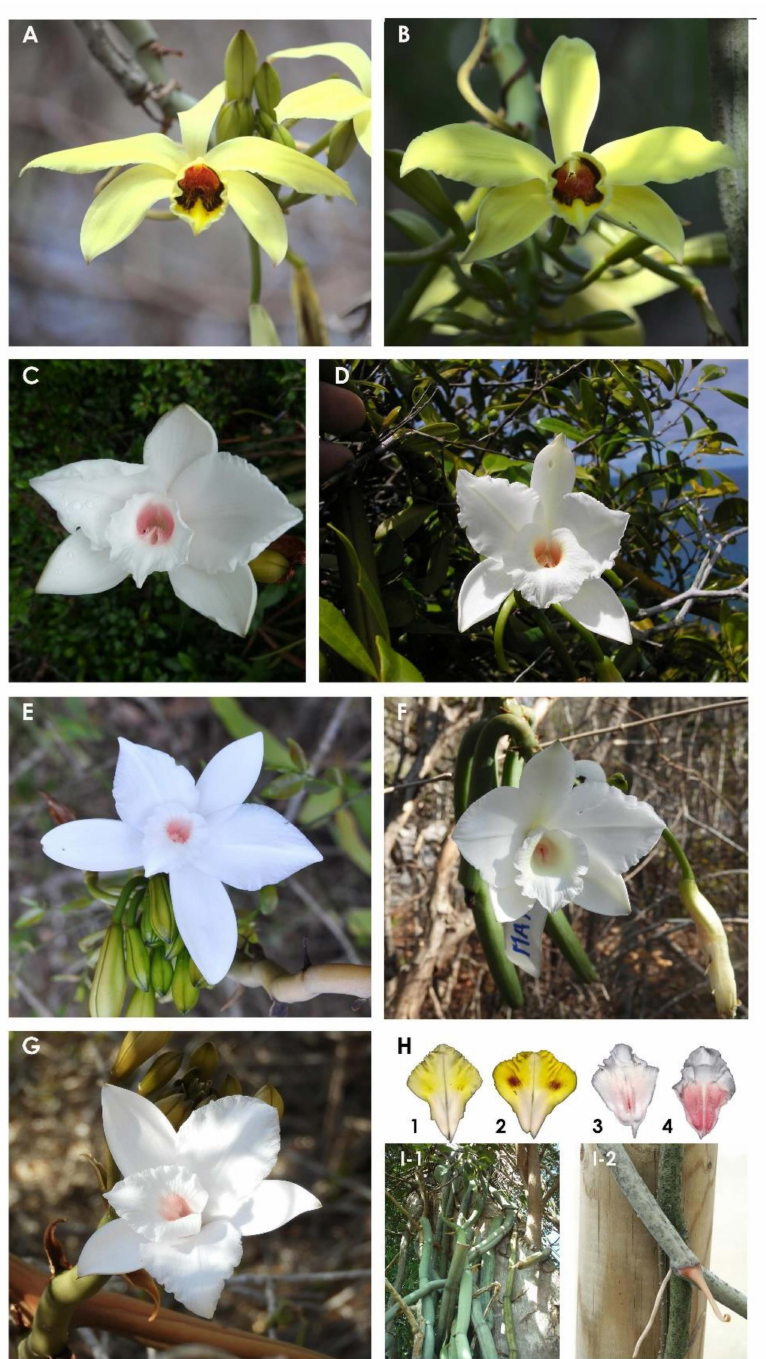
Figure 6. Morphological diversity of the seven leafless Vanilla species from the SWIO region. Flowers of ( A ): V. humblotii from Montagne des Français (Diego, Madagascar), ( B ): V. perrieri from Befandrama in the district of Analalava (Madagascar), ( C ): V. roscheri from Lake Sibaya in South Africa, ( D ): V. phalaenopsis from Seychelles, ( E ): V. madagascariensis from Maromandia in the district of Analalava (Madagascar), ( F ): V. bosseri from Marosely in the district of Port Berg é (Madagascar), ( G ): V. decaryana from Mangily in the district of Tul é ar II (Madagascar). ( H ): scan of (1) the back side of V. humblotii labellum, (2) the back side of V. perrieri labellum, (3) the inside of V. bosseri labellum and (4) the inside of V. madagascariensis labellum. ( I ): Stems of (1) V. bosseri from Antsianitia (Madagascar), (2) V. humblotii CR0108 from the Comoros (BRC Vatel collection). (Photo A, B: Johnson G. Andrianantenaina, C: Rodolphe L. Gigant, D: Thierry Pailler, E: Alemao Botomanga, F,G,H: Cathucia F. Andriamihaja, I: Pascale